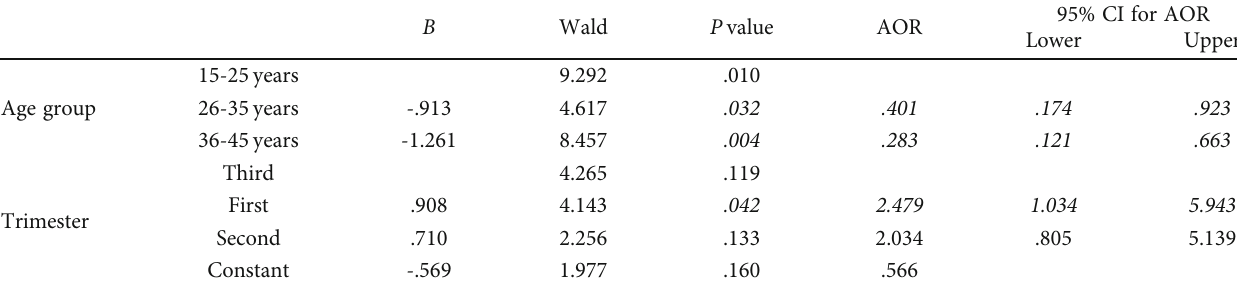
Table 5: Maternal age and trimester of pregnancy as a predictor of UTI infection in pregnant